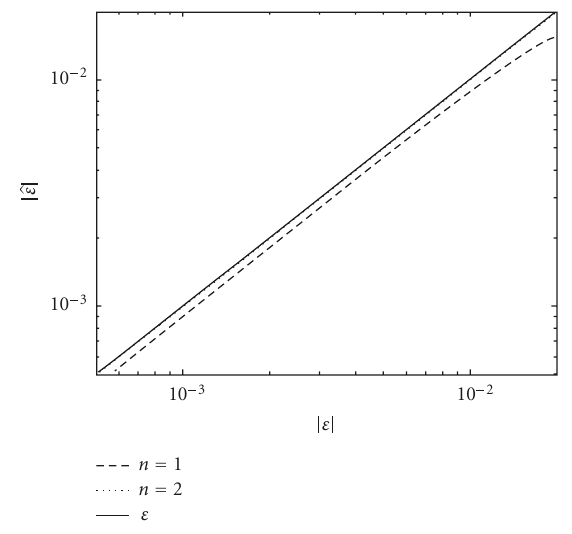
Figure 3: Comparison of the estimated time-scaling factor for n = 1 iteration, n = 2 iterations, and the true time-scaling factor ε as a function of the applied time-scaling factor. Simulated signals have a flat spectrum with B/ f 0 ≈ 0 . 77 and a 10 dB